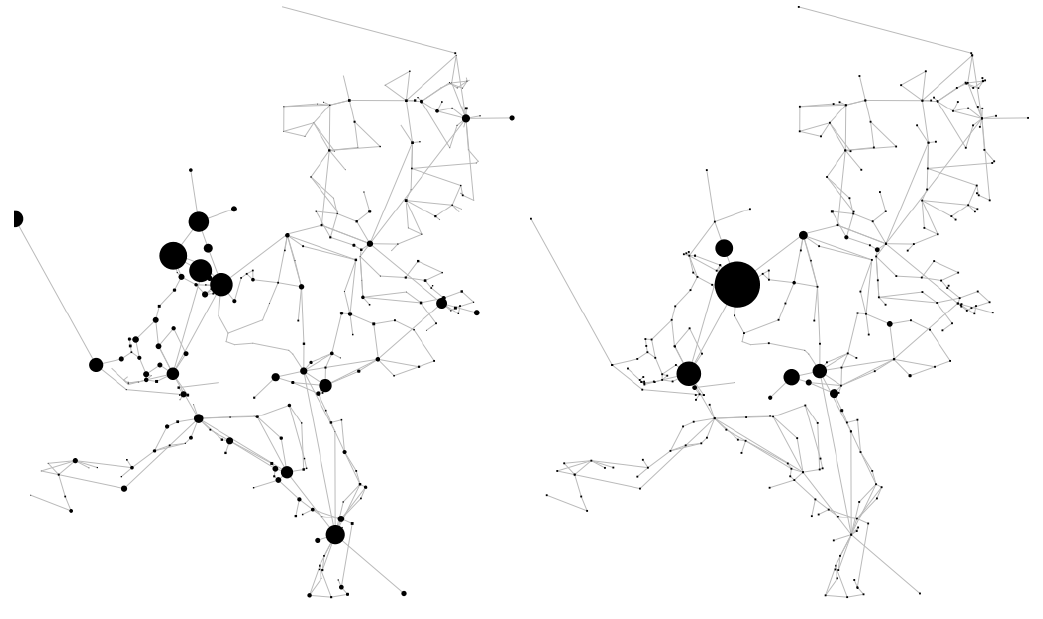
Figure 4. Illustration of the Dutch transmission system, with substations sized according to their criticality (left pane) and criticality-adjusted flood vulnerability (right pane). Substations with a higher criticality/vulnerability are larger.